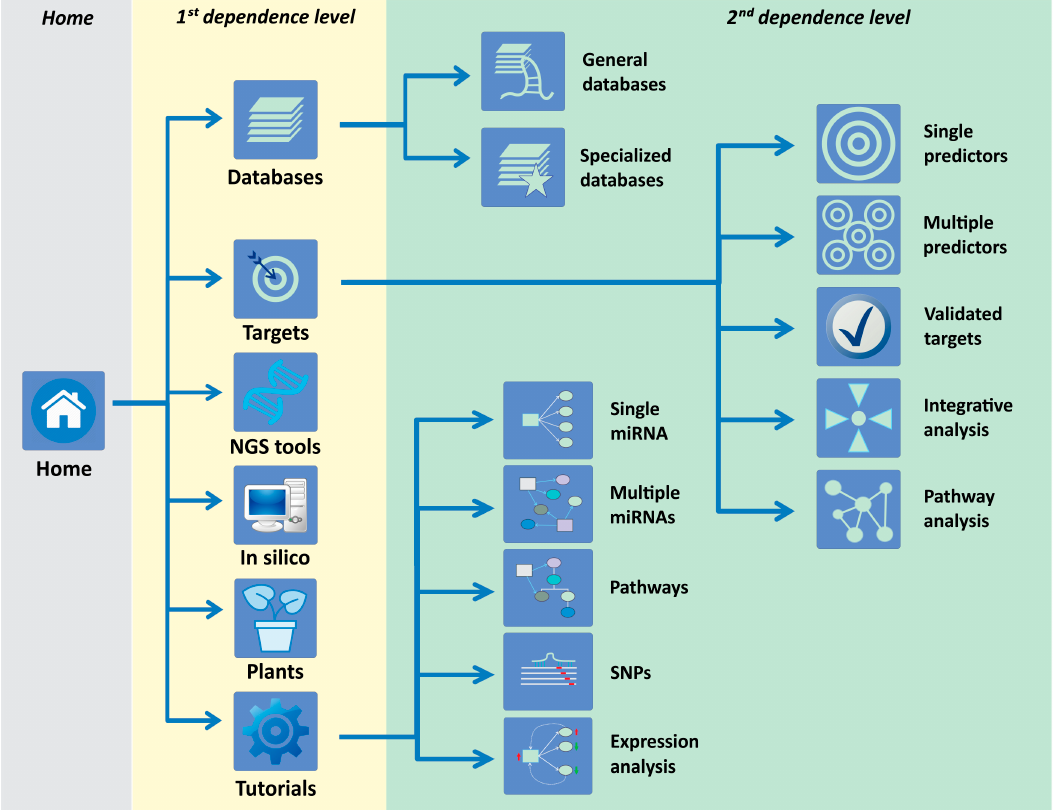
Figure 1. Navigation structure of the miRNAtools3 website showing the two main dependence levels. Navigation across sections and topics can be achieved by direct pointing over the respective icons or by using the navigation menu integrated in each sub ‐ page.